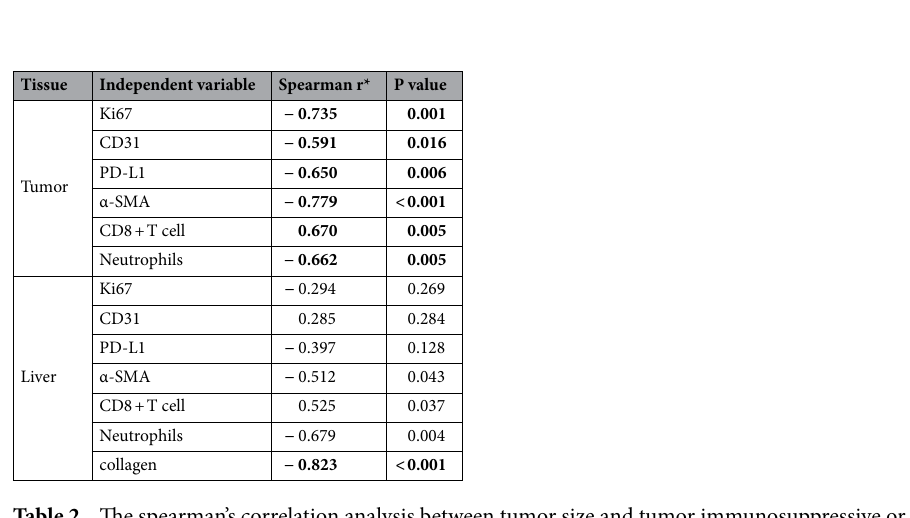
Table 2. The spearman’s correlation analysis between tumor size and tumor immunosuppressive or liver collagen deposition (n = 16). Significant values are in bold. r: 0–0.3, uncorrelated; 0.3–0.6, weakly correlated; 0.6–0.8, moderately correlated; > 0.8, strongly